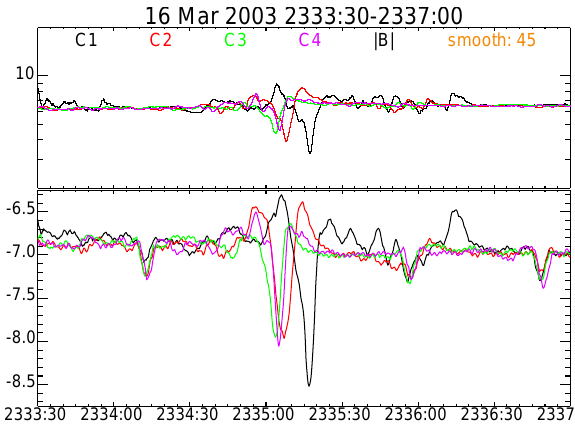
Fig.7. Fig. 7. 16 March 2003 23:33:30–23:37:00UT, magnetic field in- tensity and φ SC